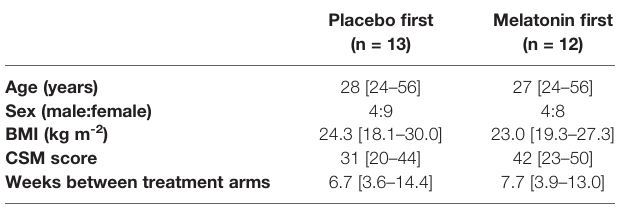
TABLE 1 | Characteristics of trial